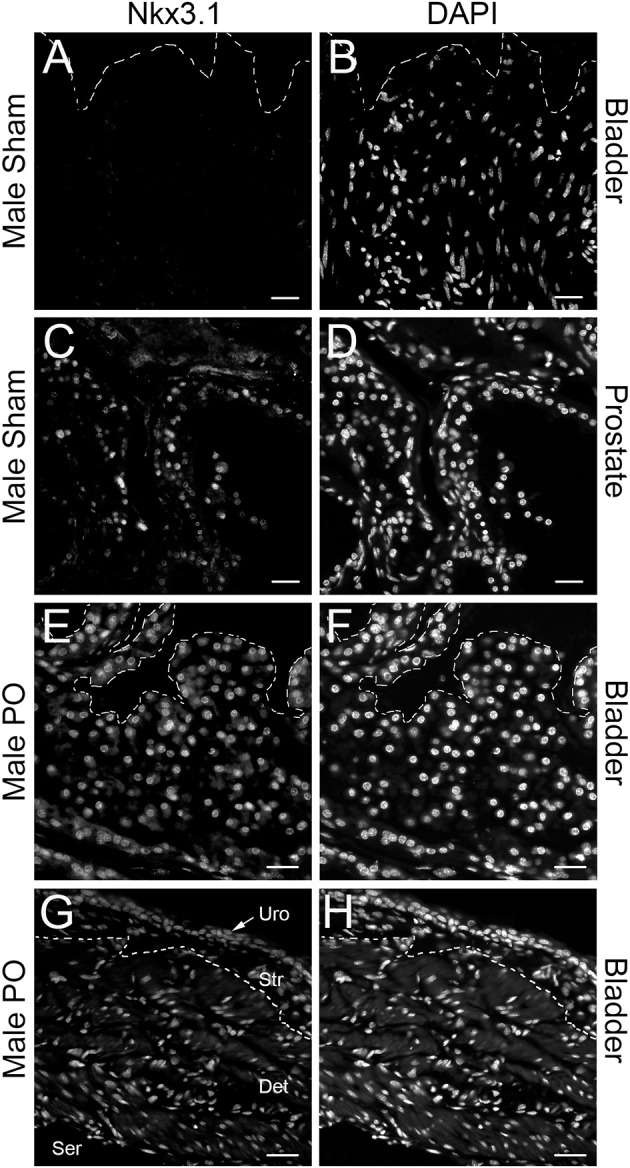
Immunolocalization of NKX3.1. Sham bladder stained with anti-NKX3.1 (A) and DAPI (B); prostate from sham animal stained with anti-NKX3.1 (C) and DAPI (D); PO bladder stained with anti-NKX3.1 (E) and DAPI (F); separate PO bladder stained with anti-NKX3.1 (E) and DAPI (F) showing lower magnification with urothelium (Uro), stroma (Str), detrusor (Det) and serosal (Ser) layers. The orientation of each bladder is presented with the urothelium at the top of each panel and indicated by a dotted line in (A,B,E,F). In (G,H) the dotted line marks the approximate border between stroma and detrusor. Magnification bars are 40 μm in (A–F) and 60 μm in (G,H).